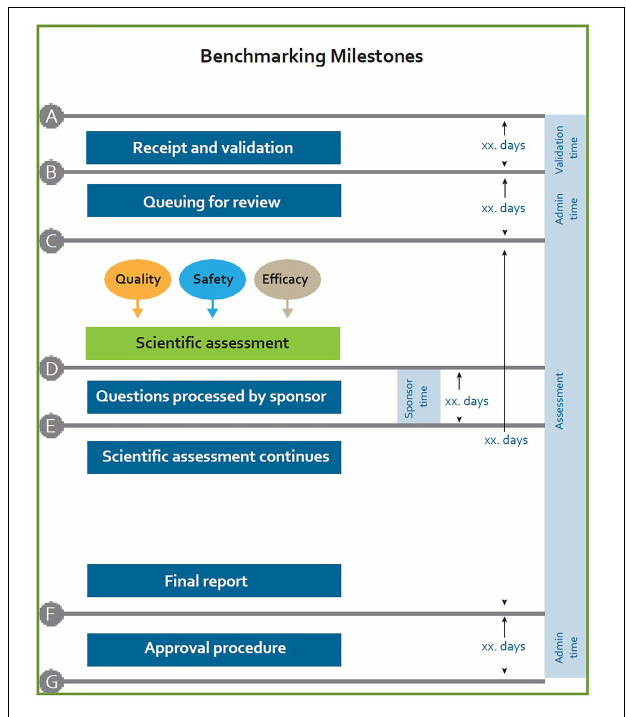
FIGURE 4 | Benchmarking milestones currently utilized by regulatory